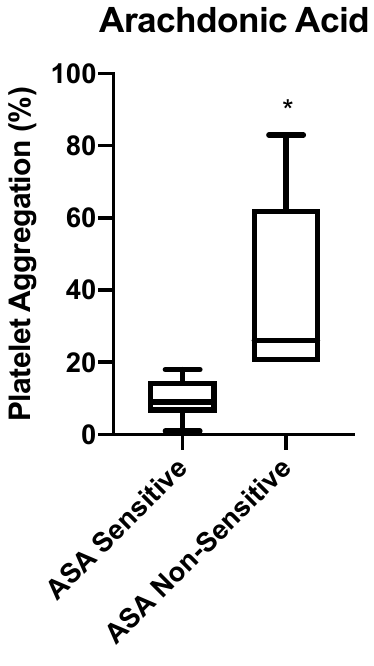
Figure 3. Baseline aspirin (ASA) sensitivity testing using LTA. Box-whisker plots depicting maximum platelet aggregation in response to arachidonic acid (AA) in patients taking 81 mg ASA. Patients were considered ASA non-sensitive if there was ≥ 20% maximal platelet aggregation. Significant difference of maximum aggregation between ASA sensitive and non-sensitive patients is represented by (*) with p < 0.0001.